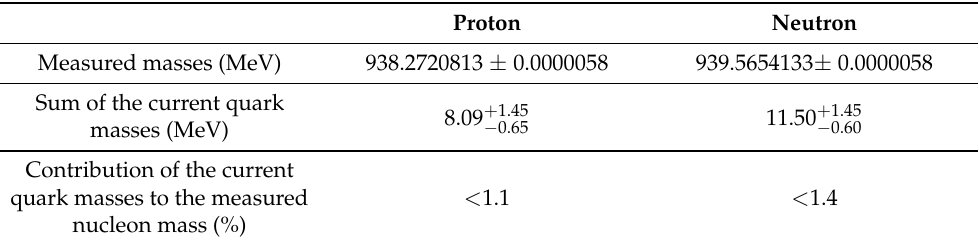
Table 1. Comparison between the measured masses of the proton and neutron, m p , n , and the sum of the current-quark masses of their three u - and d -quark constituents [76]. (Current quark masses are listed at a scale of 2GeV, but the comparison remains qualitatively unchanged if renormalization group invariant current masses are